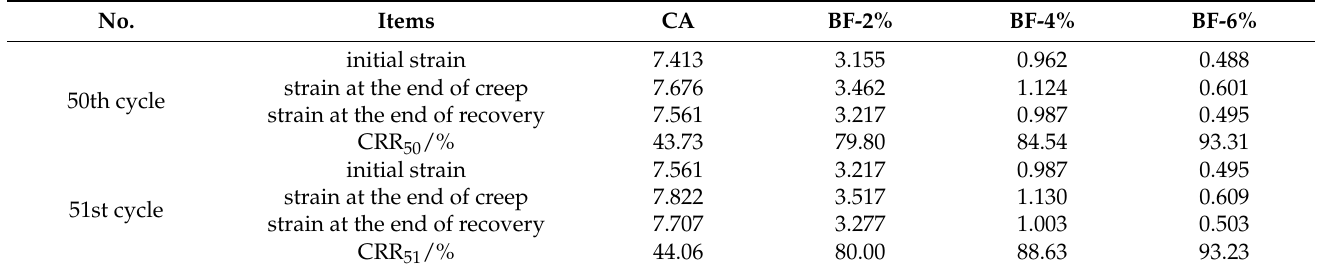
Table 5. Creep deformation and CRR of brucite fiber-reinforced CA in the 50th and 51st